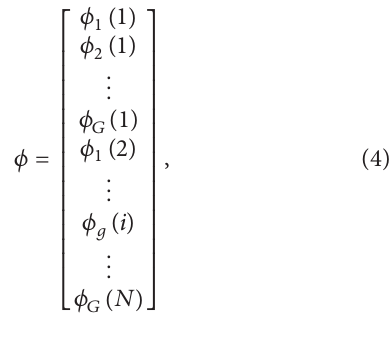
Figure 3: Cross section of a hypothetical reactor in which the control rods enter into the core from above with a certain attack angle with respect to the vertical direction.